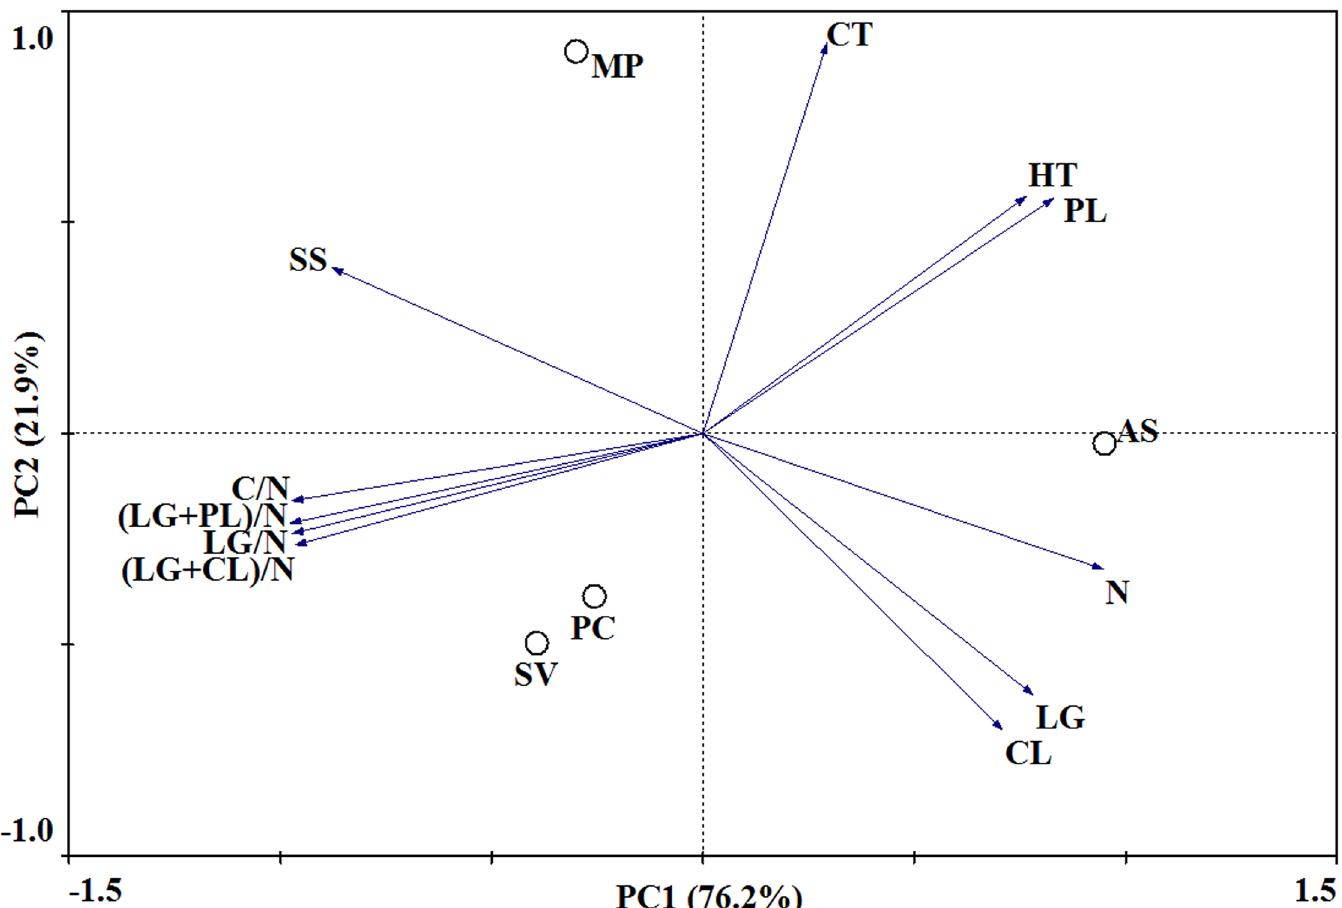
Fig 1. Principal component plot of 11 litter chemical traits of four litter species. The first two principalcomponents(PCs) accountedfor 76.2% (PC1) and 21.9% (PC2) of the total variance,respectively.LG: lignin; CL: cellulose;SS: solublesugar; PL: polyphenols; HP: hydrolyzable polyphenol; CT: condensed tannin; LG/N: lignin/N ratio; (LG+PL)/N: ratio of (lignin+ polyphenol)/N; (LG+CL)/N: ratio of (lignin + cellulose)/N; MP: Mongolianpine; AS: A . scoparia ;SV: S . viridis ;PC: P . communis .